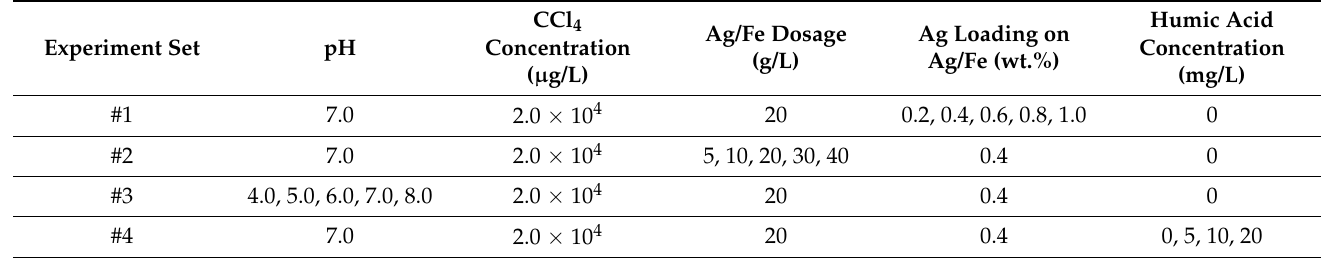
Table 1. Experiment sets for CCl 4 degradation by Ag/Fe particles.